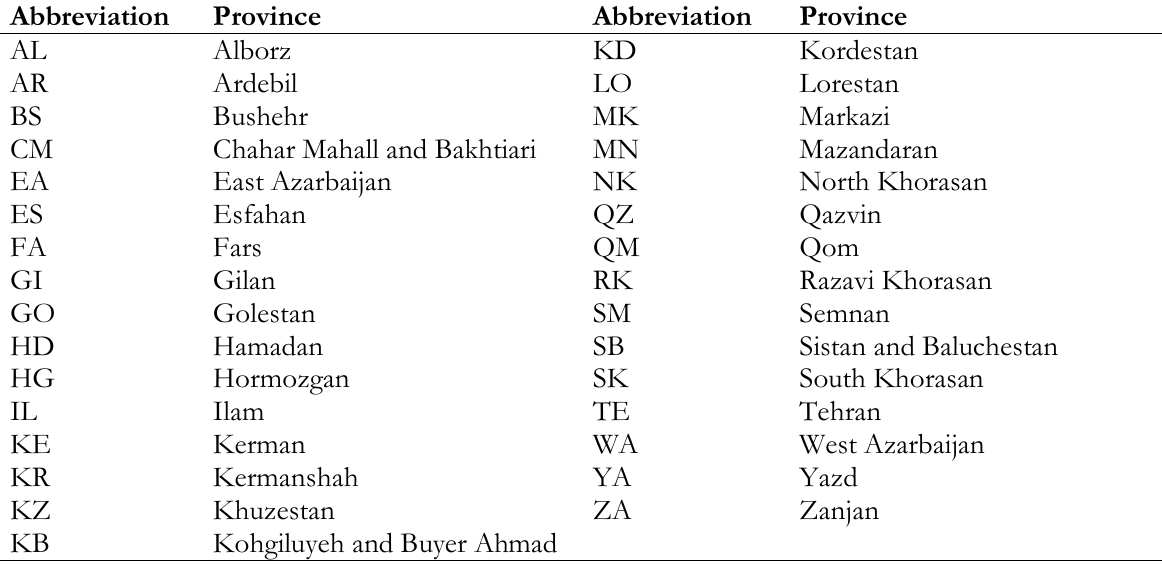
Abbreviations of Iranian provinces listed in Table 1. For showing the administrative provinces of Iran a map is given (Fig. 1). The endemic species and new records for Iranian fauna are marked with one and two asterisks,